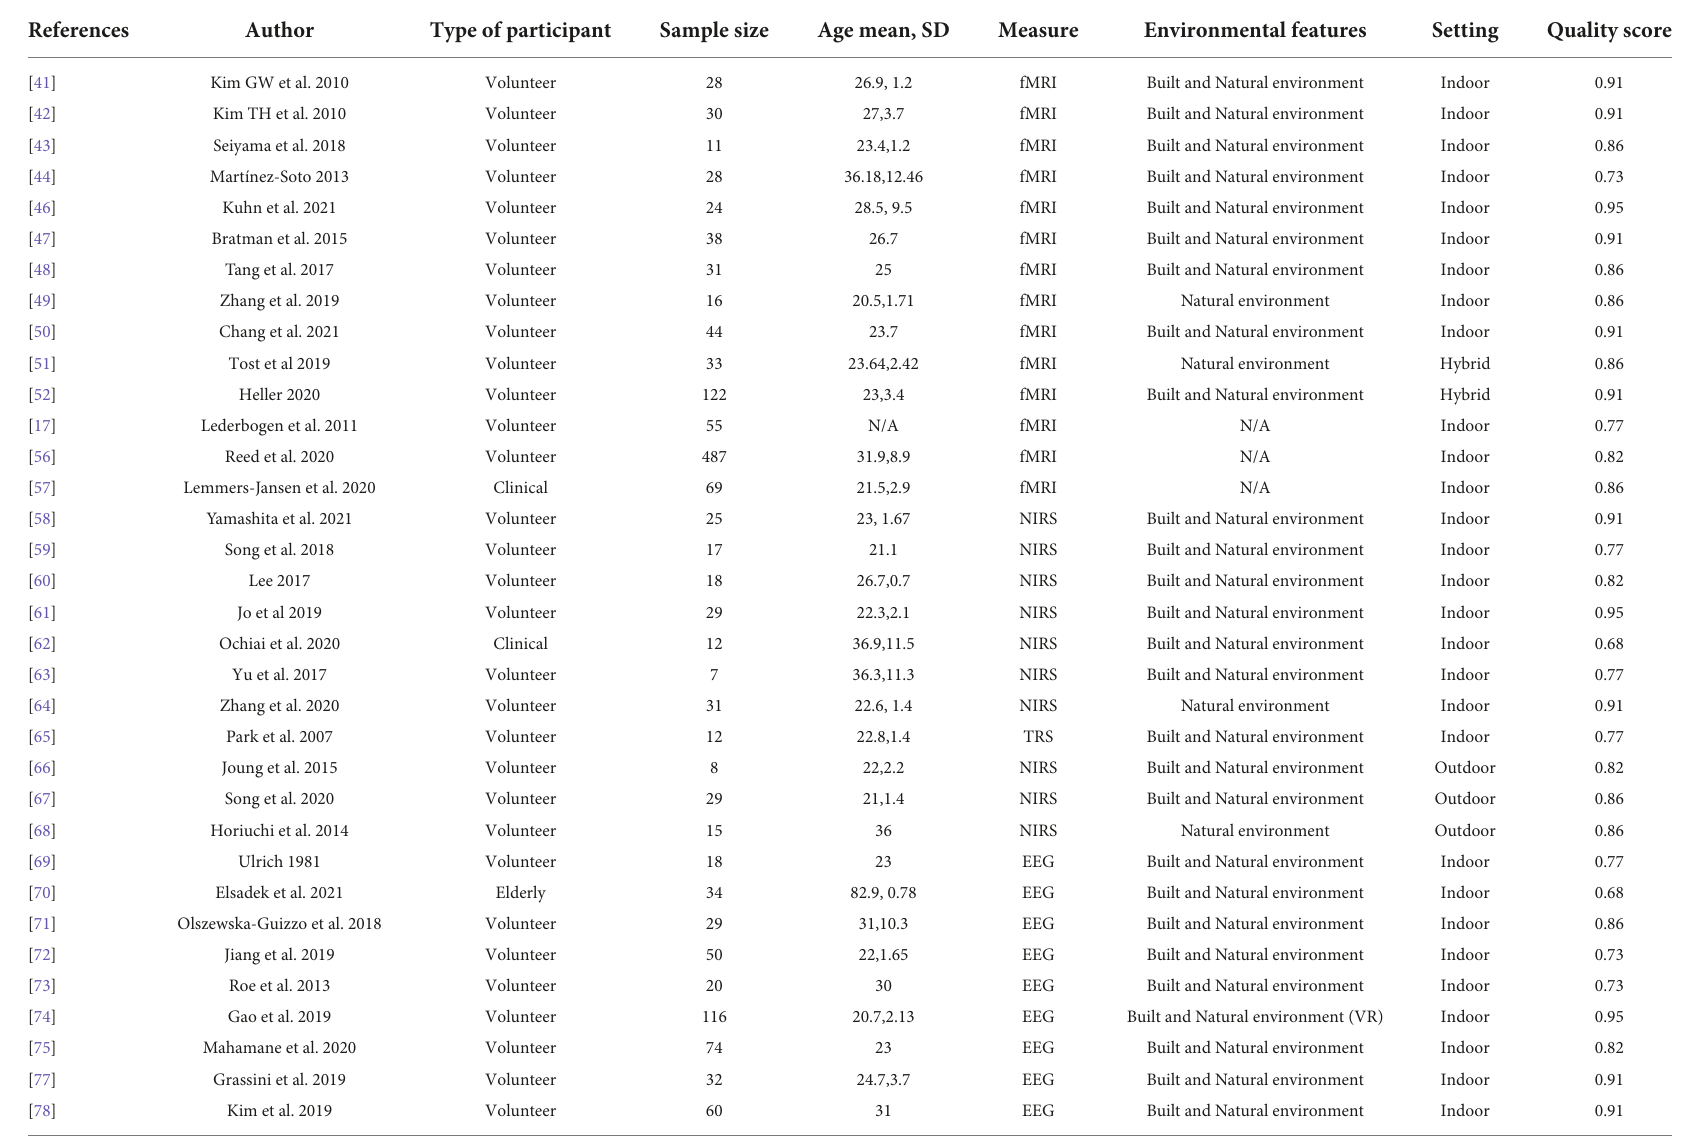
TABLE 2 Data extraction and quality